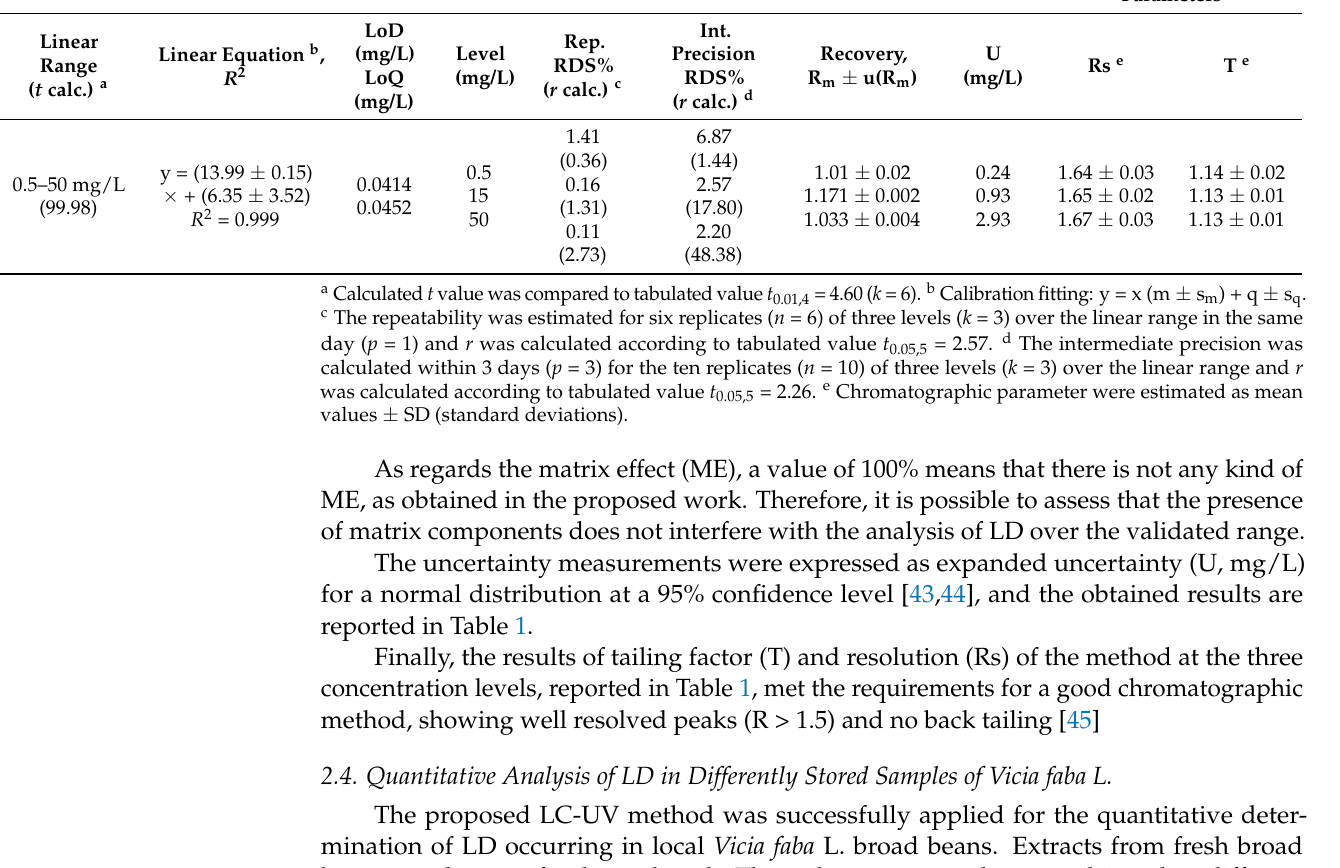
Chromatographic Parameters